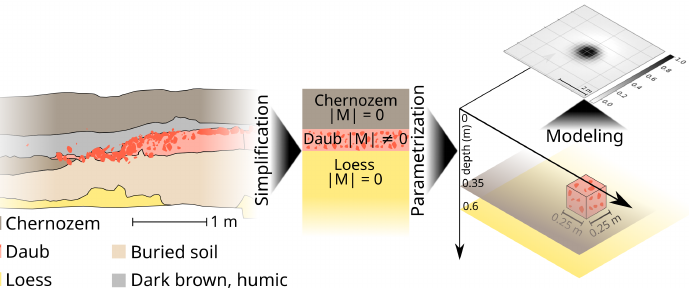
Figure 3. Schematic pathway from the archaeological section (left, after Figure 15 in [16] ) to the Green’s function R via simplification, parametrization, and modeling. Reproduced with permission from Robert Hofmann, Maidanetske 2013: New Excavations at a Trypilia Mega-Site ; published by Dr. Rudolf Habelt GmbH, 2017.